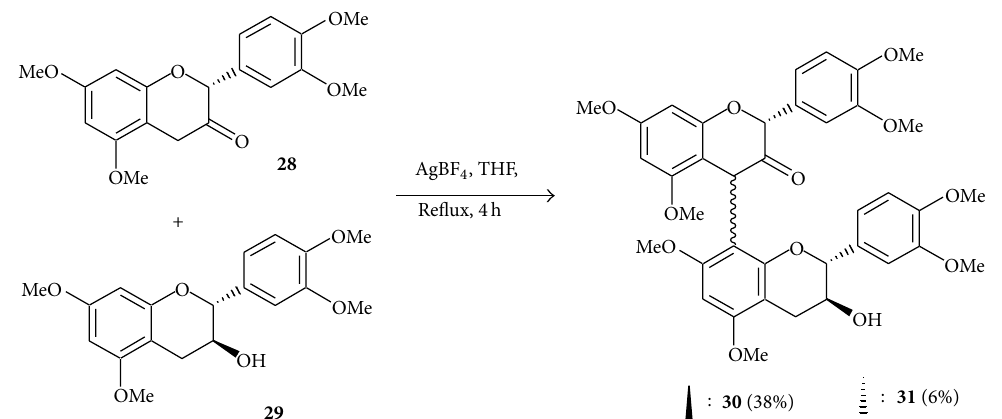
29 : Scheme 4: Condensation reaction between 28 and 29